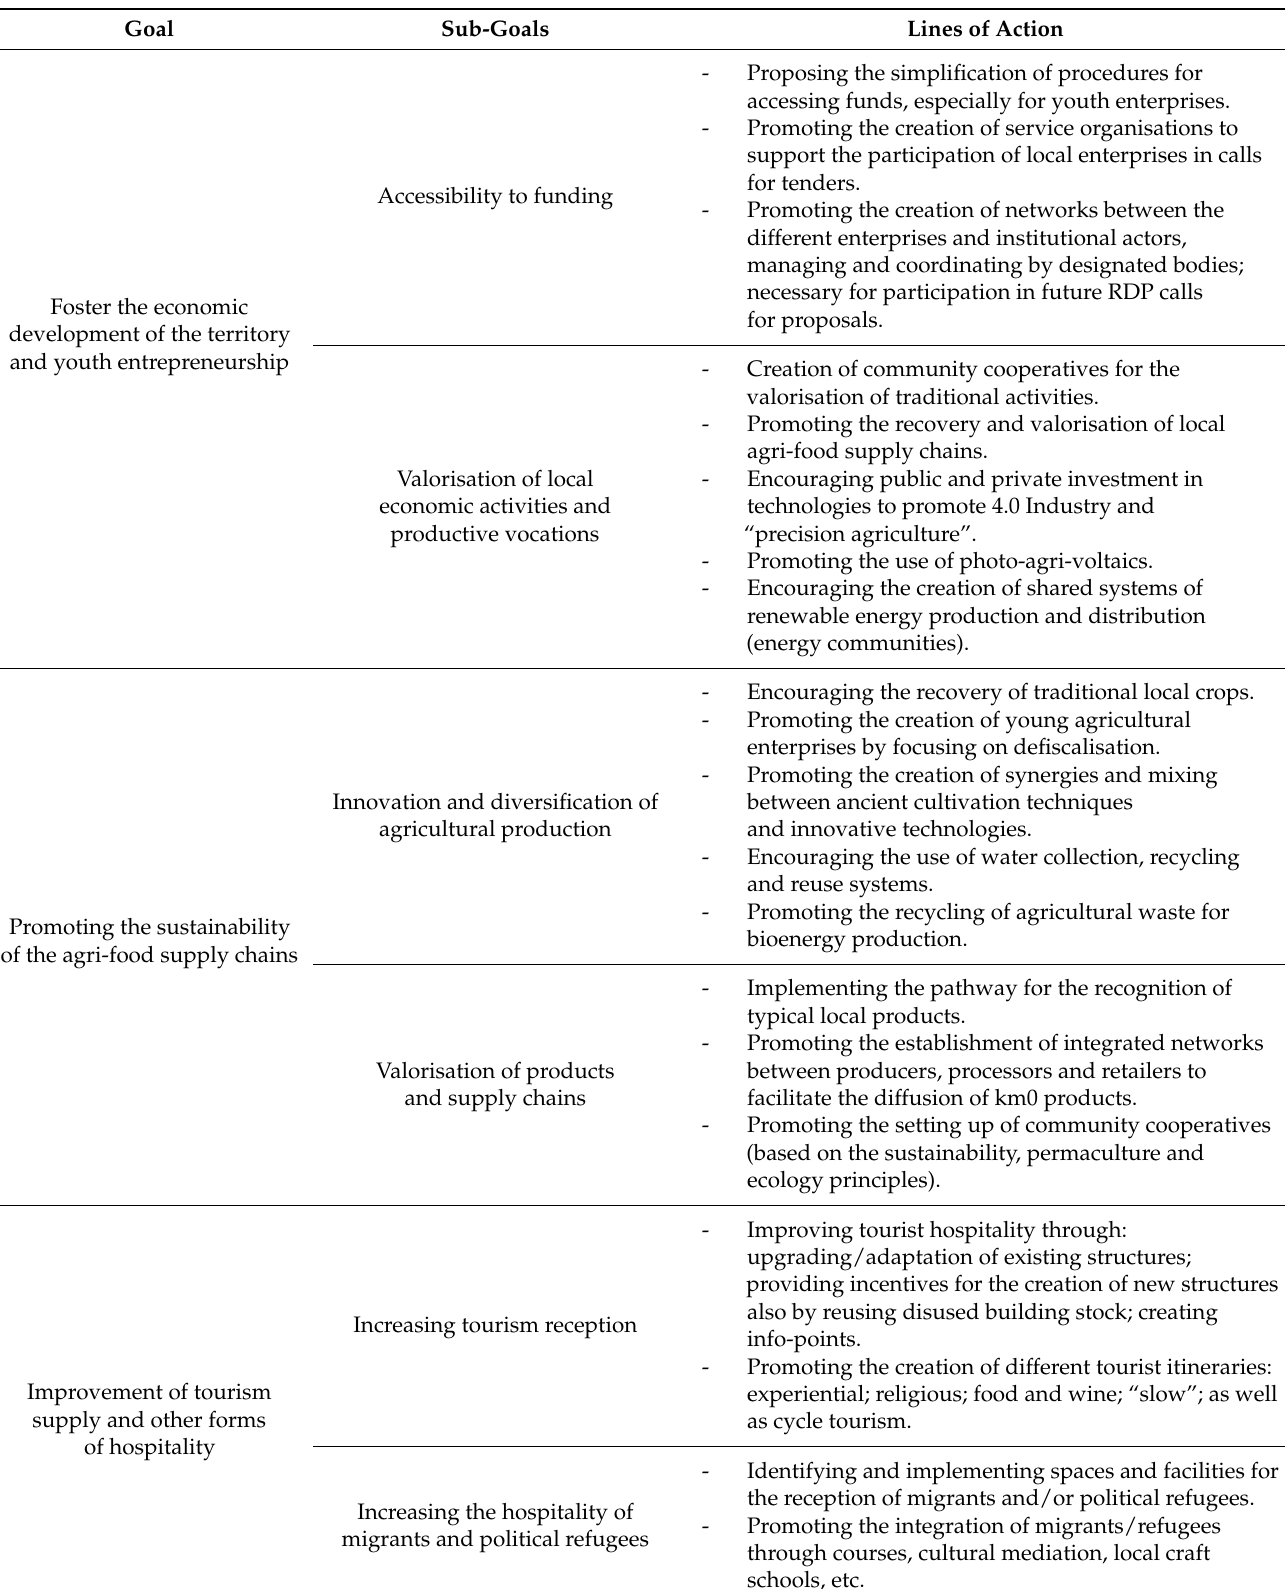
Table A2. Declination of the sub-goals for the “Productive activities and energy” strategic axis into lines of